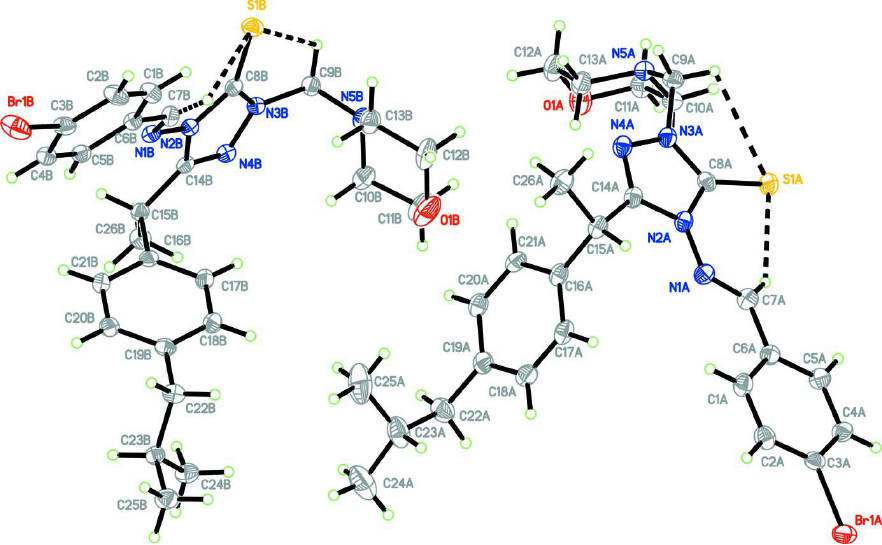
The asymmetric unit of the title compound. Displacement ellipsoids are drawn at the 50% probability level. Hydrogen bonds are shown as dashed